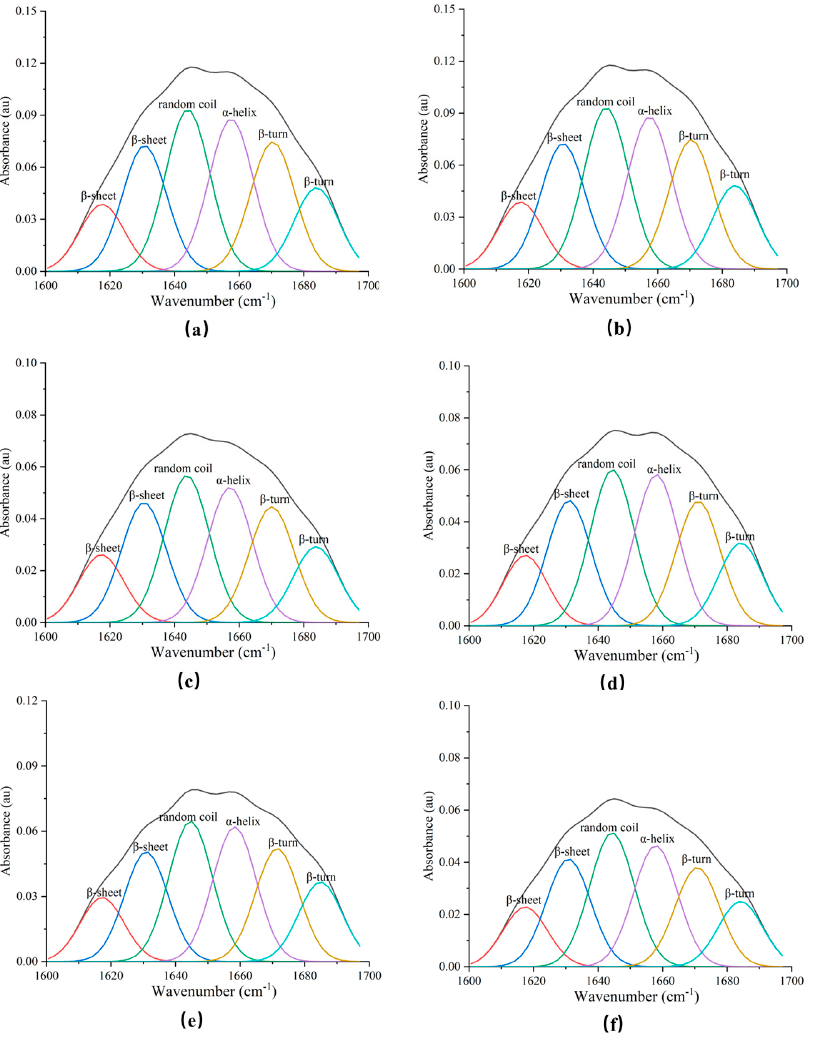
Figure 3. Fourier self-deconvoluted curve-fitted spectra for the extrudates with the different addition of cysteine (( a – f ): 0%, 0.05%, 0.10%, 0.15%, 0.20% and 0.25%).